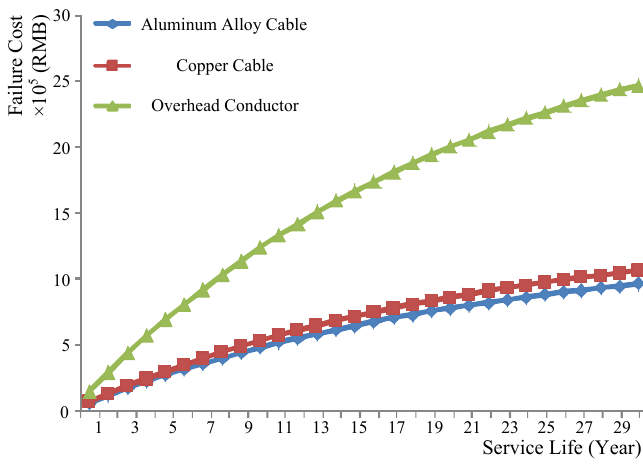
Figure 15. Failure cost during 30 years in Case 2.